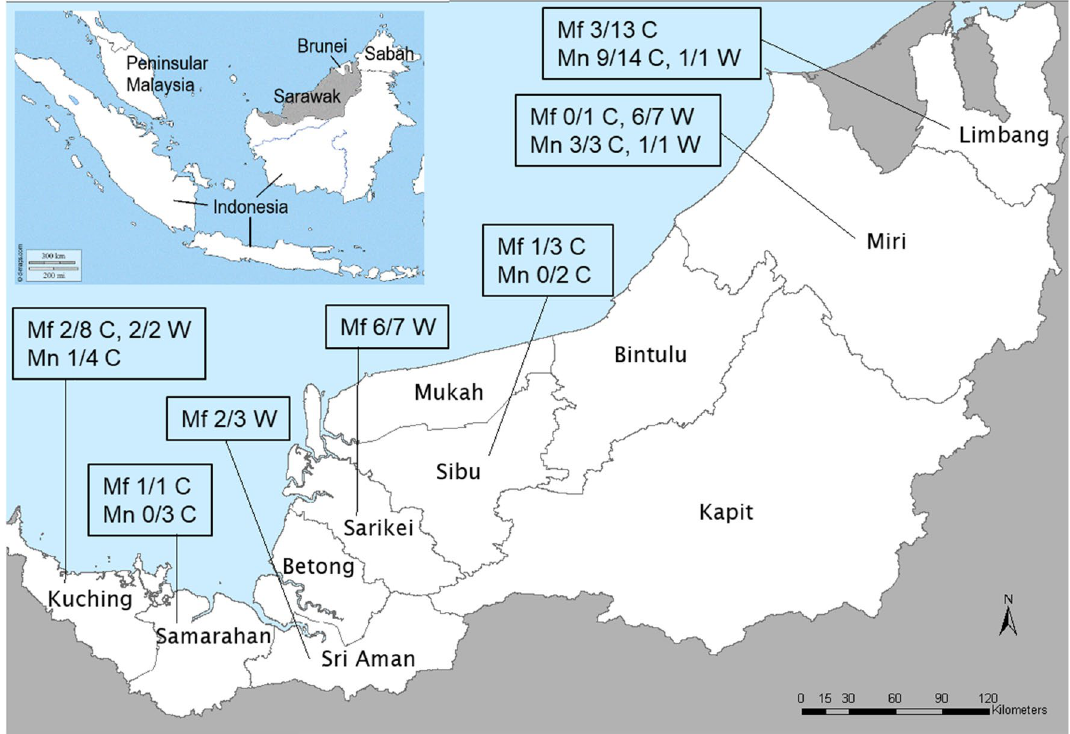
Figure 1. Prevalence of Plasmodium among macaques in the different administrative divisions in Sarawak, Malaysian Borneo. The map of Sarawak was adapted from Lee et al. 40 and modified using Paint 3D app. The inset map showing the position of Sarawak (shaded) on the island of Borneo was obtained from https://d- maps. com/ carte. php? num_ car= 28850 & lang= en and modified using Paint 3D app. Mf = M. fascicularis , M n = M. nemestrina , Number Plasmodium -positive / Number tested, C = captive, W = wild. All the captive macaques, except those at the wildlife centres in the Kuching division, were kept as pets.